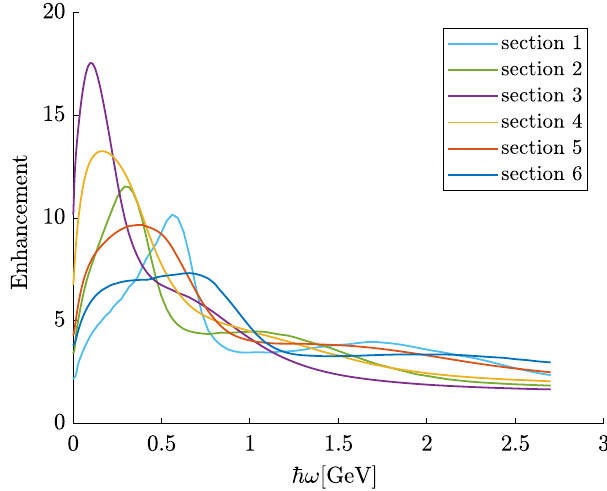
FIG. 5. Radiation spectra from 1000 12.6 GeVelectrons hitting the (111) plane of a bent silicon crystal with a bending radius of 0.15 m and an entry angle of 175 μ rad including multiple scattering. The color of each spectrum pertains to its respective 10 μ m section throughout the crystal as given in Fig. 3.